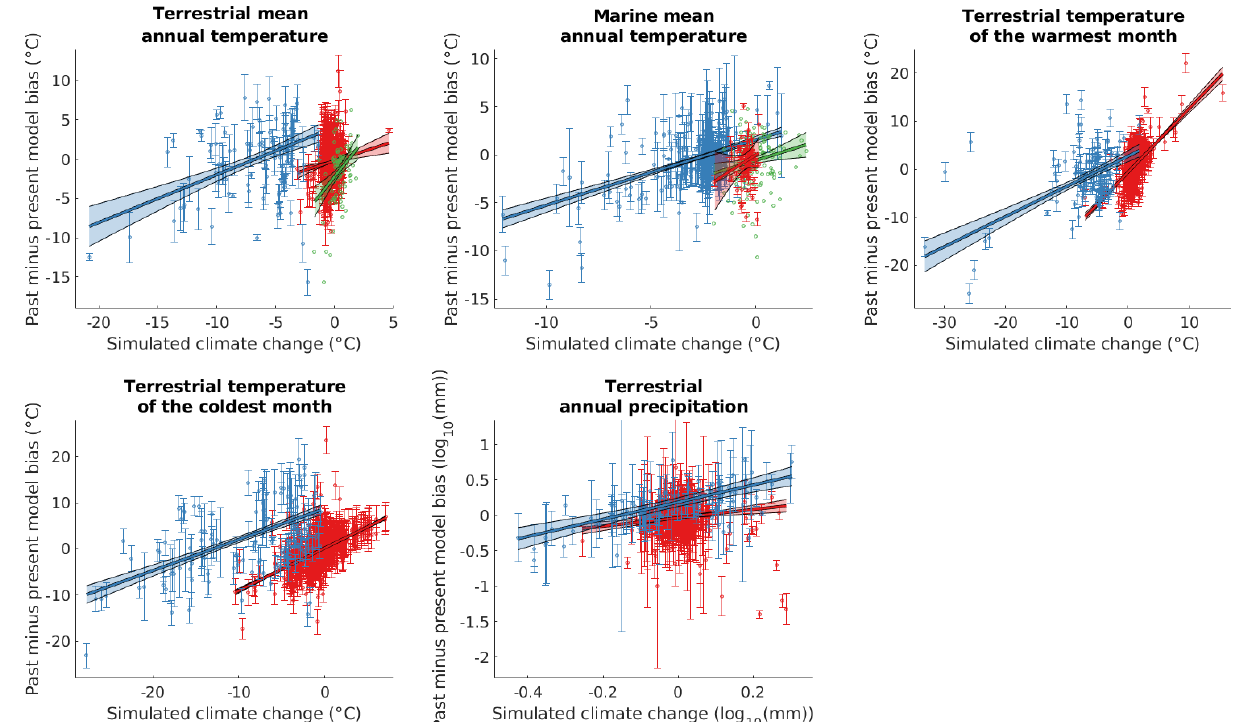
Figure 5. Differences between local past and present model bias (at locations for which empirical reconstructions are available) against the local simulated climate change signal (i.e. the difference between past and present simulated value) of the variable of interest. Red, blue, and green markers represent data from the mid-Holocene, the LGM, and the last interglacial period, respectively. Error bars represent standard errors of the empirical reconstructions. Lines and shades show robust linear regressions and 95% confidence intervals, respectively. Whilst weak, the relationships suggest that it may be possible to model some of the variability of local model biases over time using only the available simulation data. Such an approach could potentially significantly enhance the delta method, which currently operates on the simplifying assumption that this variability is